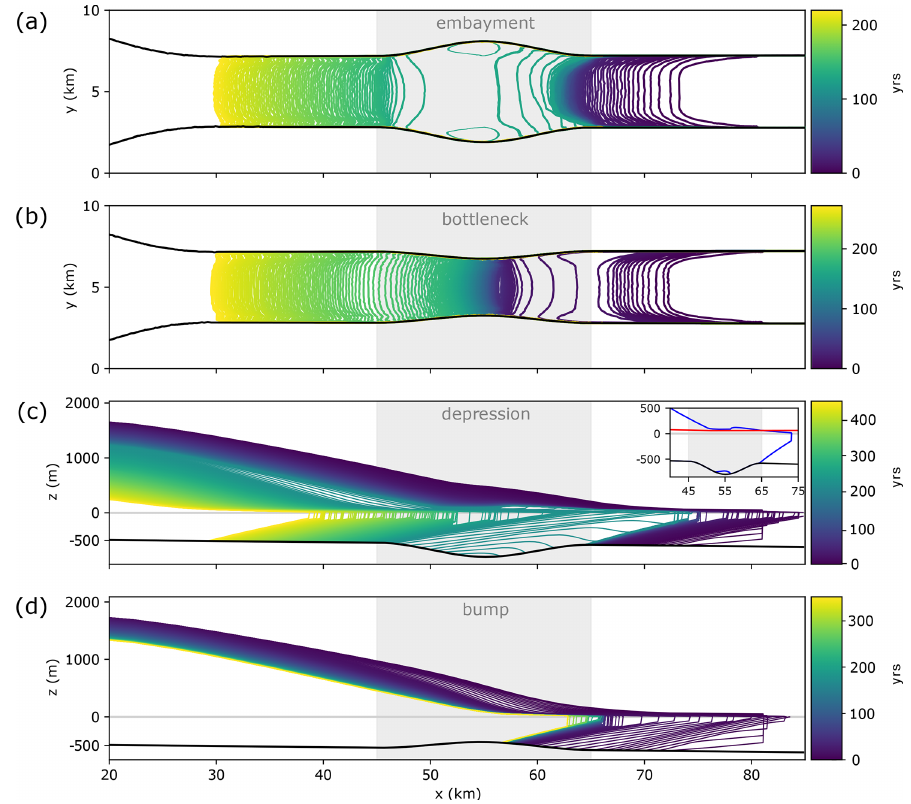
Figure 3. Annual glacier evolution ( a , b : top-down view of domain showing yearly grounding lines; c , d : yearly glacier profiles along central flow line) in fjords featuring different geometric perturbations (location of perturbations marked in gray) with the spacing between the lines indicating retreat velocity: (a) medium embayment, (b) small bottleneck, (c) medium depression, (d) small bump. Inset plot in (c) shows profile (blue) in year 217 when glacier ungrounds in the central part of the depression, which triggers further retreat. The red line is the level to which a glacier needs to thin to reach